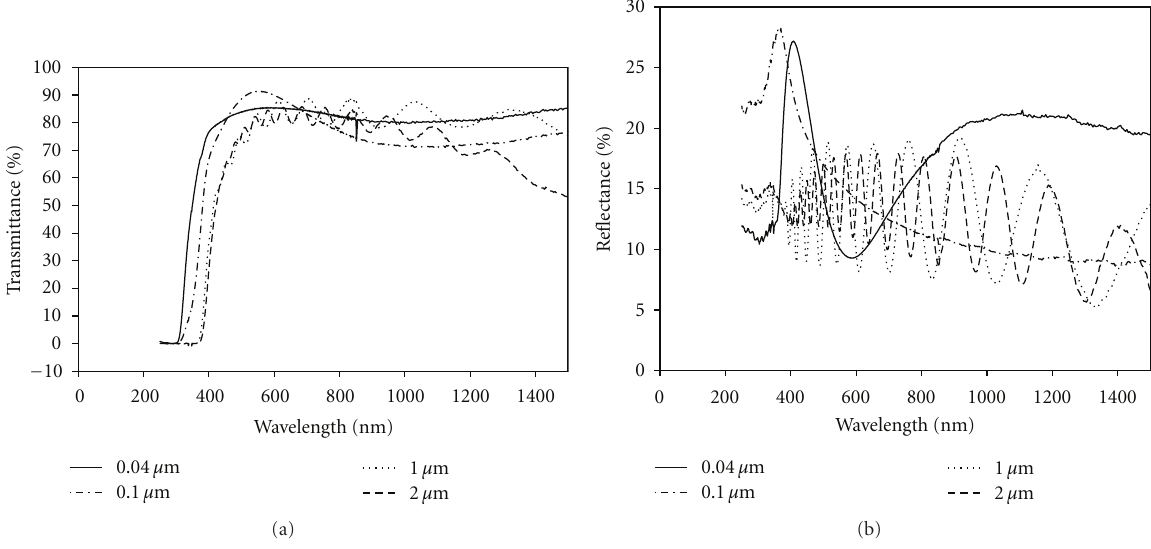
Figure 7: Transmittance and reflectance data for the ZnO:Al 2 O 3 films grown from powder targets at di ff erent thickness.